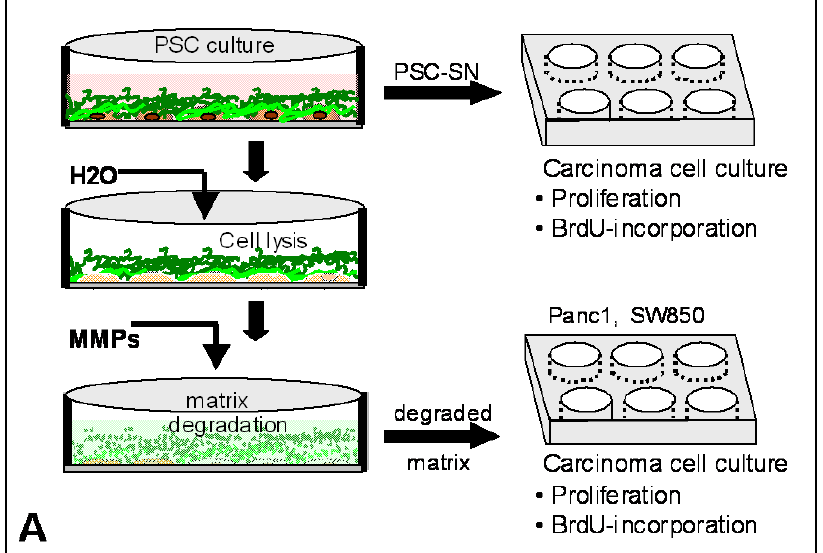
Figure 6. Effect of PSC supernatants (PSC-SN) and degraded extracellular matrix on proliferation (BrdU-incorporation) of cultured Panc1 cells. (a) Activated PSC were cultured in 6-well plates until confluency. Then, medium was changed and in the absence of fetal calf serum new medium was conditioned for 3 days. The PSC supernatant was used to stimulate Panc1 cells (see b). The cultured PSC were washed and then lysed using distilled water. After another 3 washing steps the remaining ECM was degraded at 37 °C by addition of 2ml CC supernatant (containing proteases and MMPs). Degraded matrix was (b) , PSC supernatant was added to cultured Panc1 and proliferation was quantified by BrdU-incorporation. (c) Degraded matrix (with and w/o preincubation with neutralizing antibodies) was added to cultured Panc1 and proliferation was quantified by BrdU- incorporation. * p <